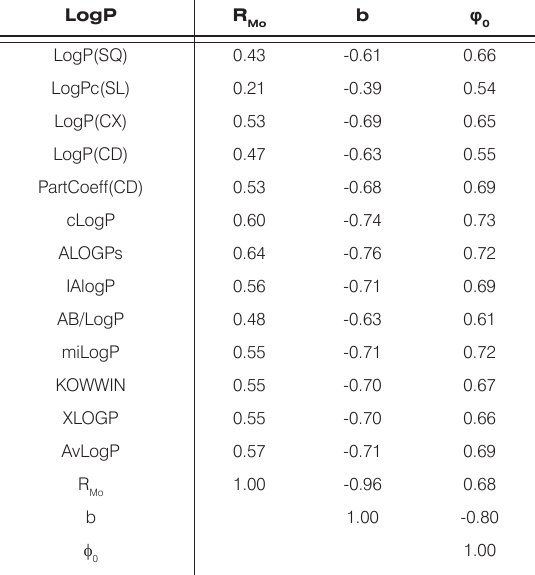
Table 4. Correlation matrix for lipophilicity indices obtained on RP-TLC plates with computed log P